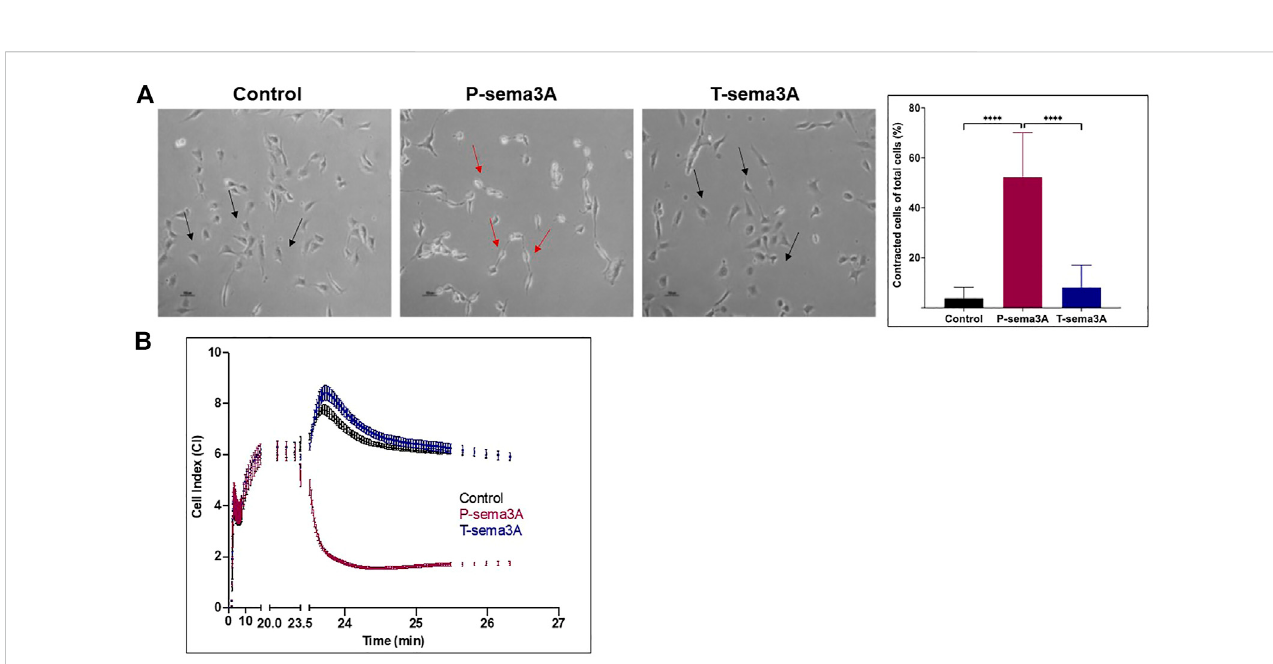
FIGURE 2 Truncated sema3A is unable to induce NRP-1 mediated signaling in endothelial cells (A) . Cell contraction assay was performed on HUVEC cells in the presence of 200 ng/mL of puri fi ed P-sema3A or T-sema3A or an appropriate amount of acontrol elutionbuffer for 30 min at 37 ° C. After the incubation time, the cells were photographed using a phase-contrast inverted microscope: A round shape is the natural morphology of the HUVEC (black arrow), while as a result of sema3A, the cytoskeleton collapsed, and the cells lost their round shape (red arrows). The quanti fi cation graphs represent the percentage of contracted cells from total cells (N = 8 independent experiments). The results were analyzed using Kaluza software, and the statistical signi fi cance was calculated using one-way ANOVA and Kruskal – Wallis test (**** = p-value < 0.0001). (B) . Quantitative real-time contraction assay was performed on